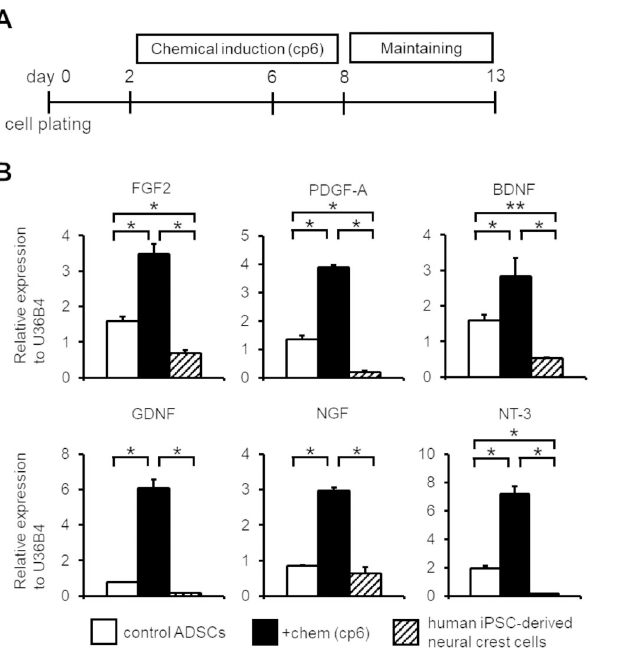
Fig 3. Small molecular treatment enhanced expression of various trophic factor encoding genes in human ADSCs. (A) Schematic of the cell preparation. After the chemical induction of human ADSCs, induced cells were maintained for 5 days in maintenance medium. (B) qPCR analysis of various trophic factor among control ADSCs, chemical (the cp6 condition)-treated ADSCs on day 13, and human iPSC-derived neural crest cells. The expression values were normalized to that of U36B4. (n = 3, error bar shows SDs; one-way ANOVA Tukey post-test). � P < 0.01, �� P < 0.05.